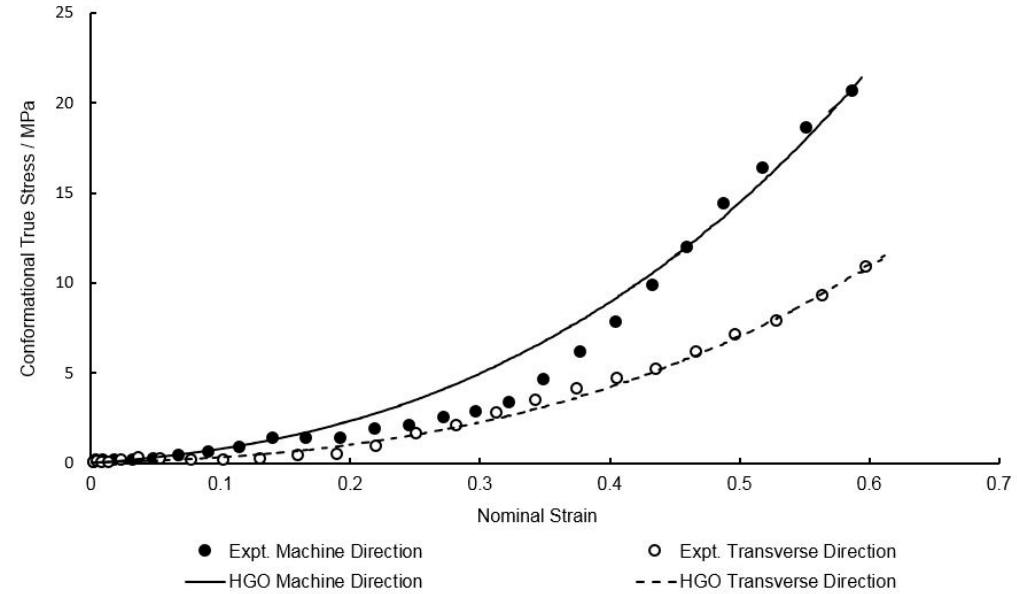
Figure 13. Non-linear curve fitting of Holzapfel–Gasser–Ogden (HGO) model to conformational stresses at a temperature of 130 °C and strain rate of 1 s − 1